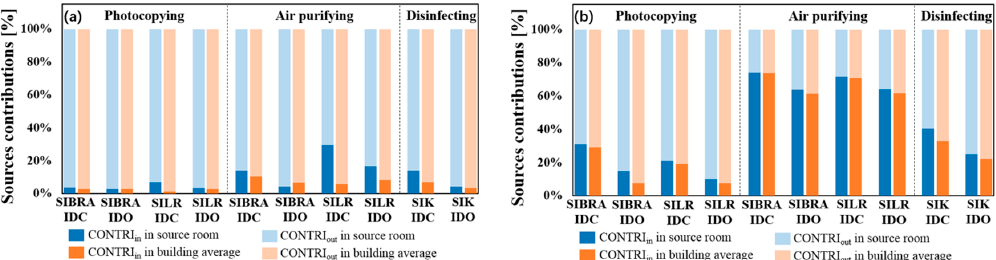
Figure 6. I / O ratio frequency of source room and building average ( a ) in summer, ( b ) in winter.